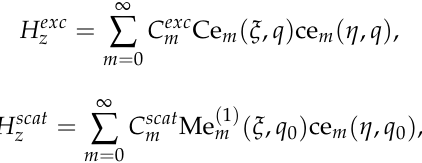
Figure 8. Eigenfrequencies k 0 R ε of even ((30), blue curves) and odd ((31), red curves) perfect invisibility modes and quasi-normal modes (black curves) versus 1/ ε for the ellipse with a / b = 1.6, m = 1.3. The horizontal dashed lines correspond to confined modes, that is, the solution of the equations Ce m ( ξ 0 , q ) = 0 and Se m ( ξ 0 , q ) = 0. The insets show the H z distribution for the PTM modes.